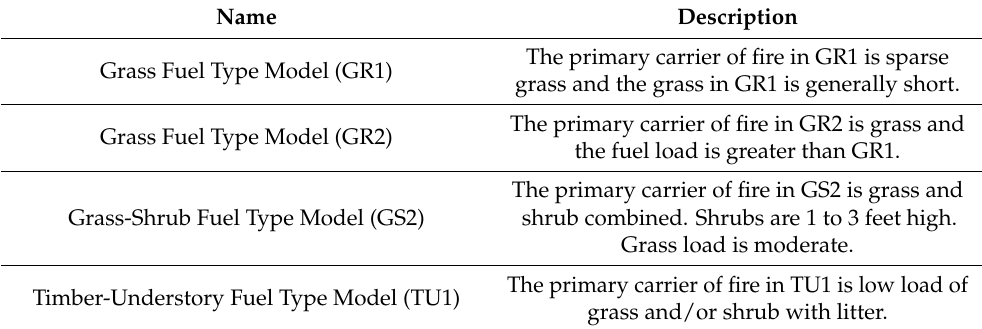
Table 1. The selected fuel types from the Scott and Burgan Fire Behavior Model